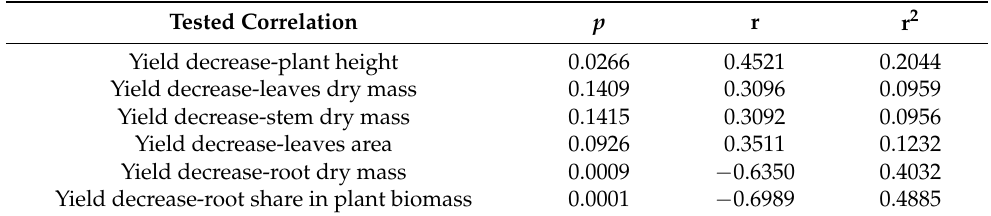
Table 5. Correlation coefficients between the selected morphological parameters of potato plant and yield decrease in relation to the control under drought and heat stresses applied simultaneously. Tested Correlation p r r 2 Yield decrease-plant height 0.0266 0.4521 0.2044 Yield decrease-leaves dry mass 0.1409 0.3096 0.0959 Yield decrease-stem dry mass 0.1415 0.3092 0.0956 Yield decrease-leaves area 0.0926 0.3511 0.1232 Yield decrease-root dry mass 0.0009 − 0.6350 0.4032 0.0001 −